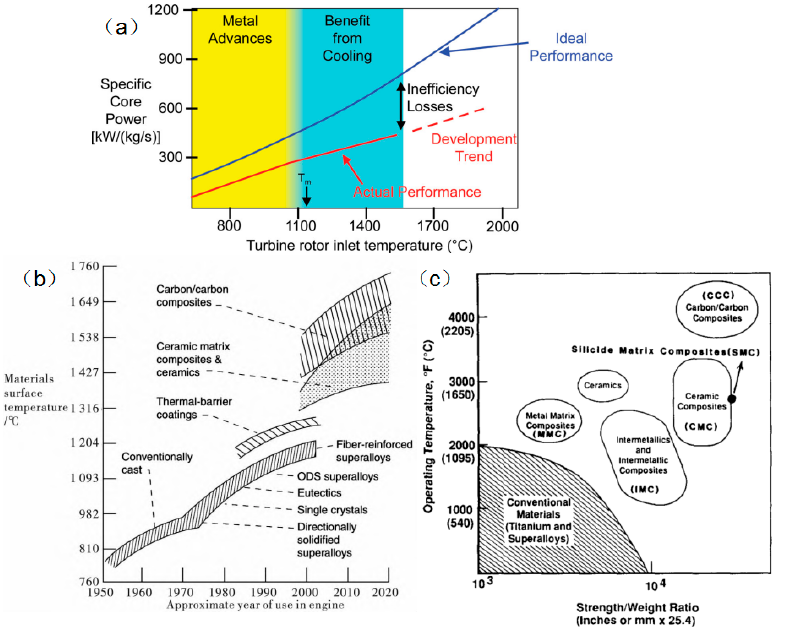
Figure 1. ( a ) Core power versus turbine inlet temperature for selected gas turbine engines; ref. [3]. ( b ) The role of high-temperature materials in the historical evolution of the turbine blade surface temperature in aeroengines. ( c ) The ranges of operating temperature and strength/weight ratio for different classes of materials [4]. Table 1. Potential materials system application at high temperatures.